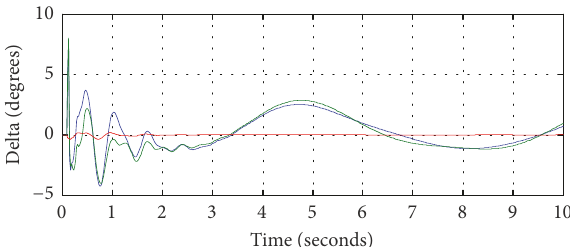
Figure 16: Actuator deflections in AOA tracking of a sinus